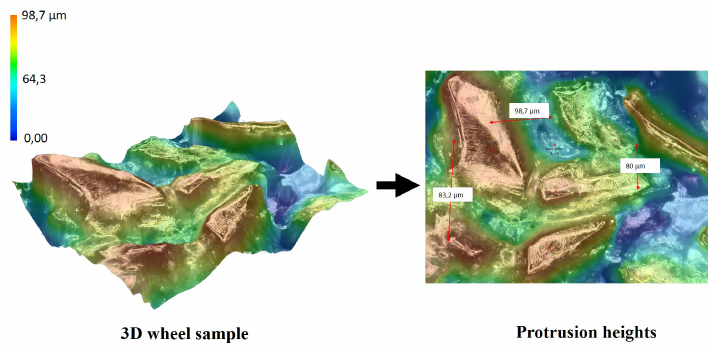
Figure 27. Detected 2D surface topography.